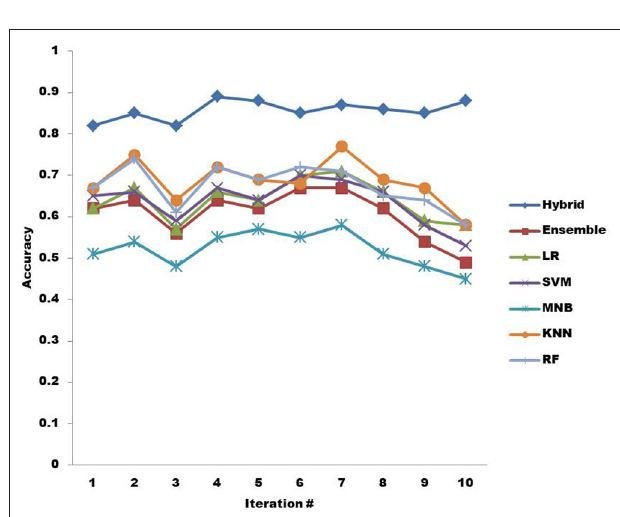
FIGURE 6 | Accuracy of machine learning algorithms with